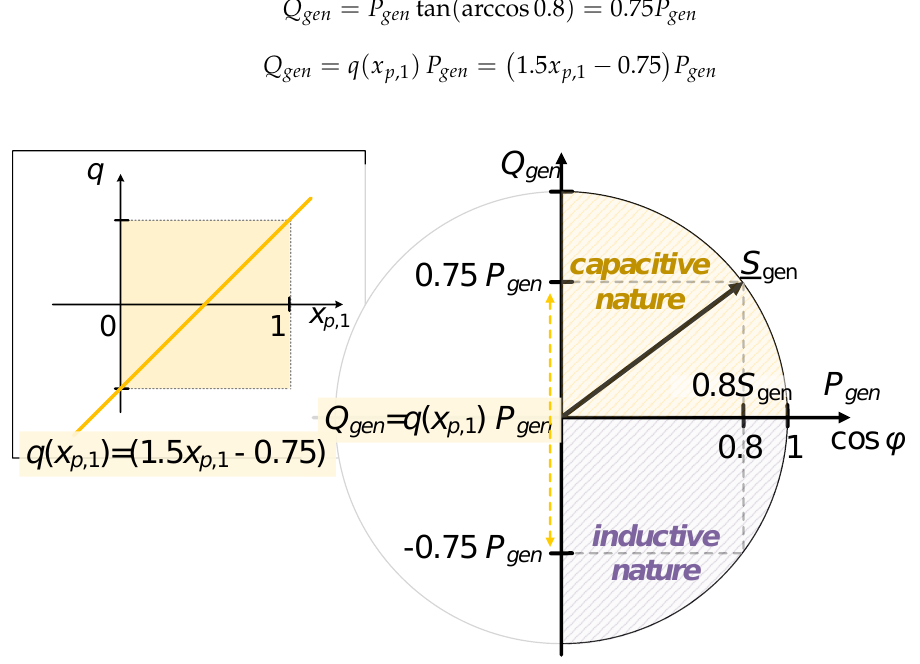
Figure 2. Phasor diagram of a complex